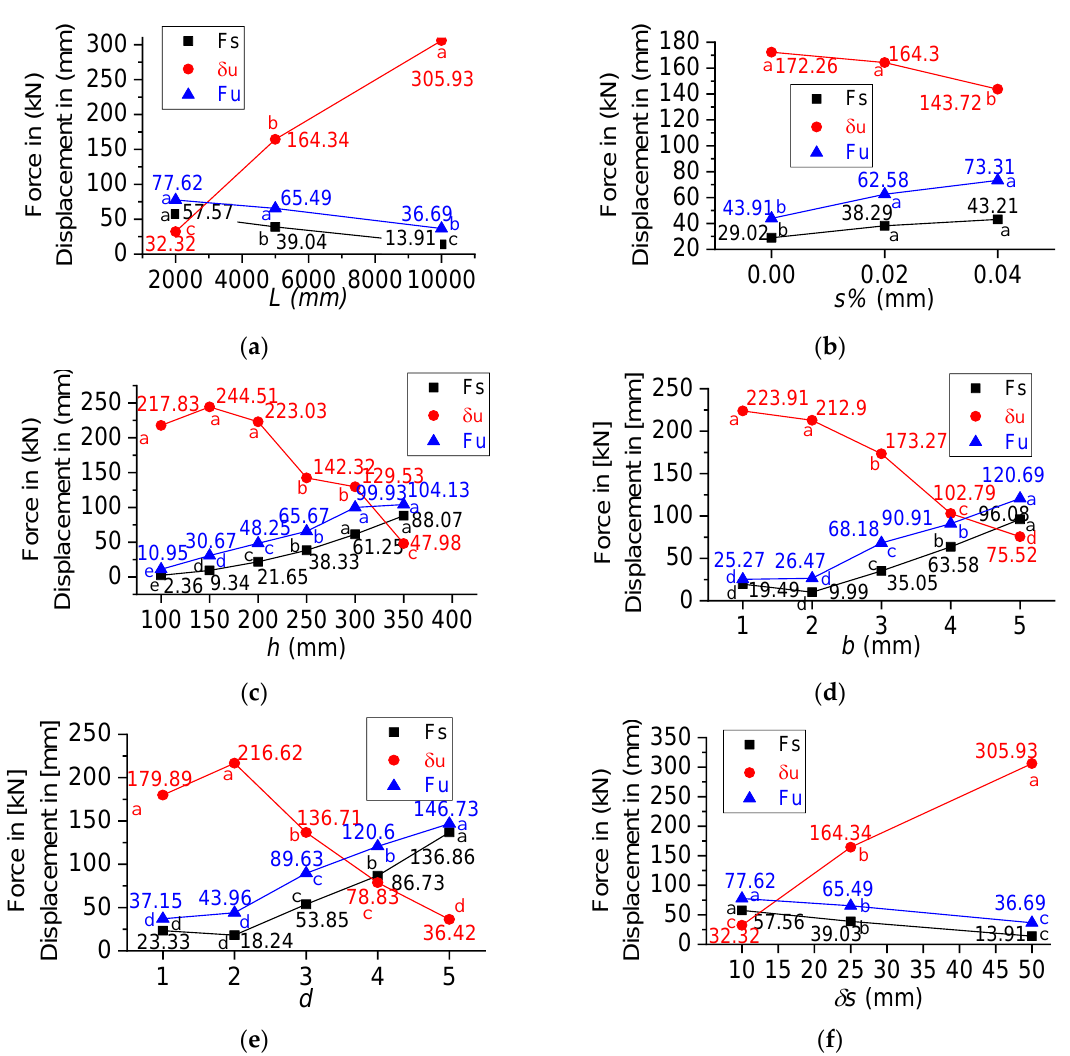
Figure 7. Tukey test results of the variables: ( a ) L ; ( b ) %s ; ( c ) h ; ( d ) b ; ( e ) d ; and ( f ) δs in relation to the force determined at the limit of the service condition ( Fs ), ultimate force ( Fu ), and last displacement ( δs ). From the Tukey test, at the 5% significance level, “a” denotes the highest mean value of the property, “b” is the second-highest mean value, and so on, and the same letters imply different treatments with statistically equivalent means.